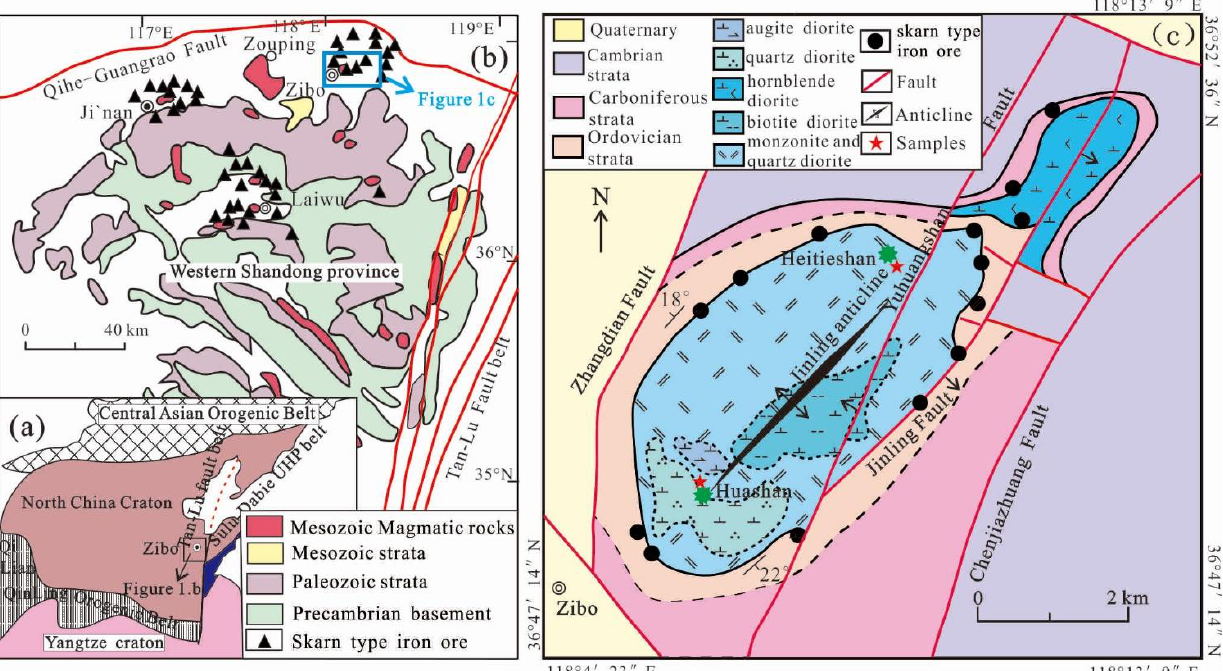
Figure 1. ( a ) The tectonic location of western Shandong area; ( b ) simplified geological map of western Shandong area; ( c ) simplified geological map of Jinling pluton in western Shandong province (modified after reference [11]). Cambrian strata are composed of shales and limestones, Carboniferous strata are composed of shales and slates, and Ordovician strata are composed of limestones. Mesozoic strata are composed of Triassic and Jurassic sandstones and shales, while Paleozoic strata are composed of Cambrian strata, Ordovician strata, and Carboniferous strata.